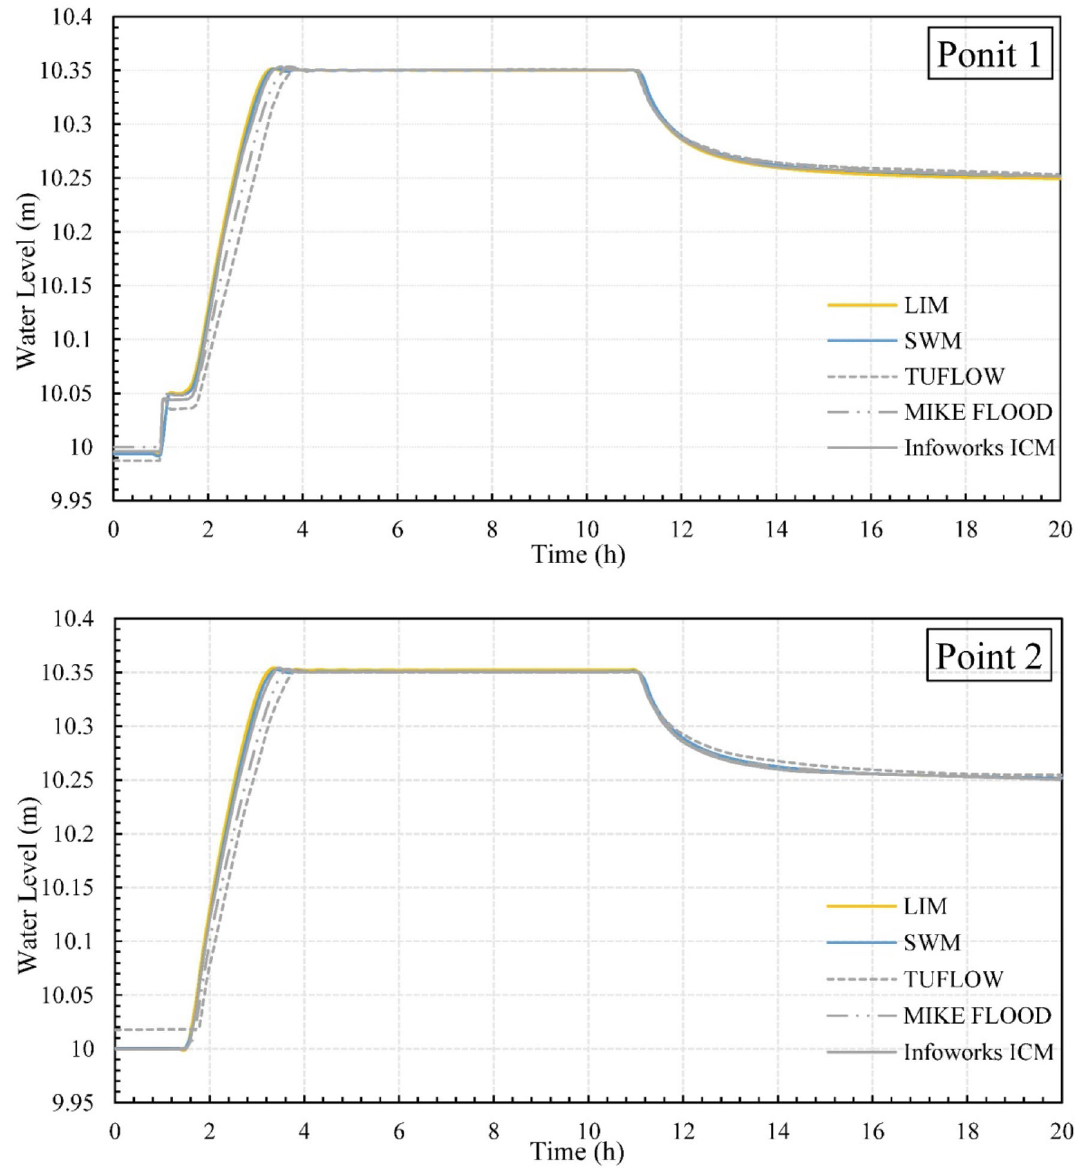
Fig. 4 Comparison of the water level at points 1 and 2 for the flooding test of a disconnected water body based on the local inertial approximation form model (LIM), shallow water model (SWM), and business software